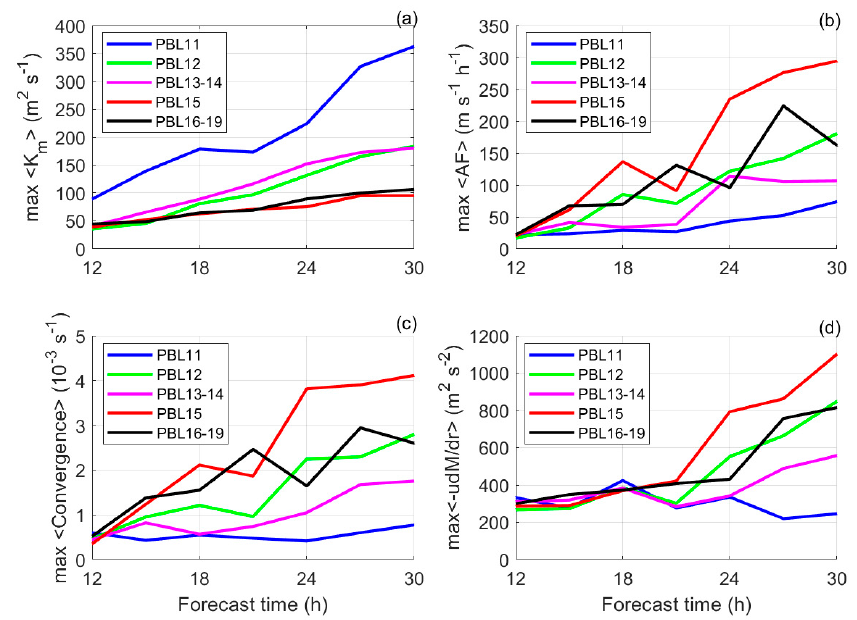
Figure 15. Time series of ( a ) the maximum azimuthally averaged vertical eddy diffusivity (< K m >), ( b ) the maximum azimuthally averaged agradient force per unit mass (< AF >), ( c ) the maximum azimuthally averaged convergence in the PBL, and ( d ) the maximum azimuthally averaged radial advection of absolute angular momentum ( ‐ u d M /dr) in the idealized HWRF simulations with 5 different PBL schemes during the rapid intensification period (t = 12 – 30 h).